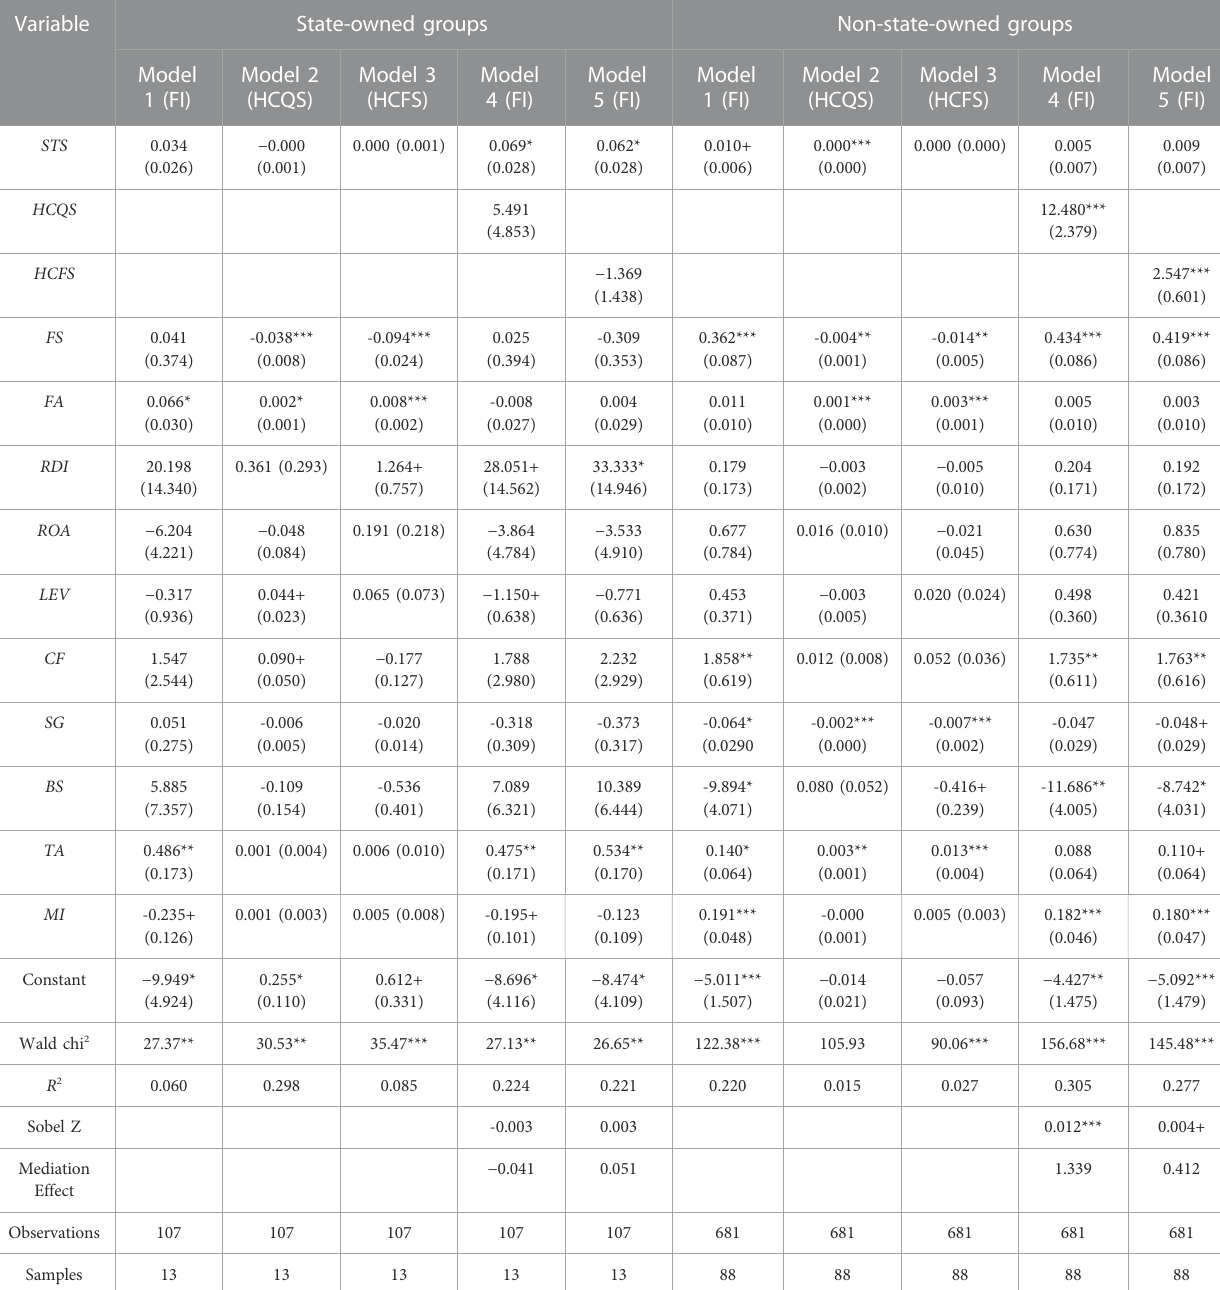
TABLE 16 Regression analysis of state-owned and non-state-owned groups based on the additional control variables.